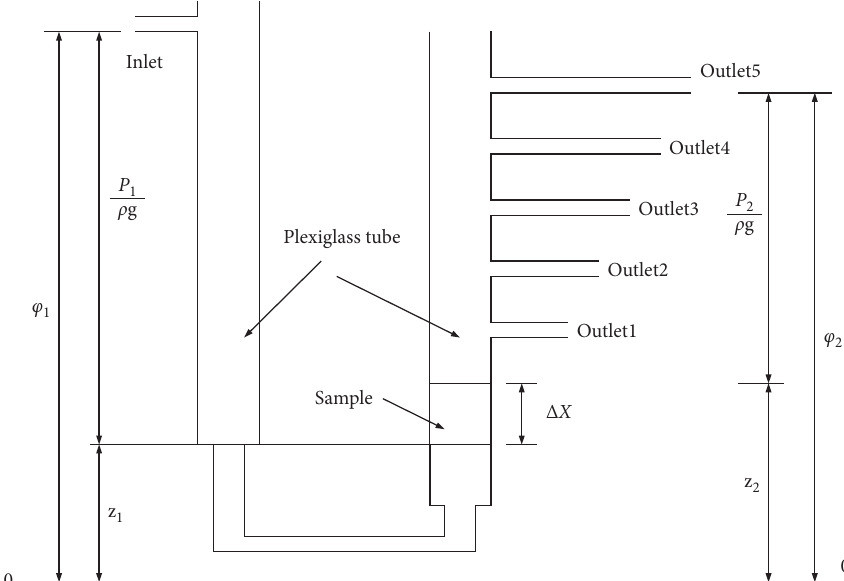
Figure 5: Schematic diagram of non-Darcy flow permeability coefficient